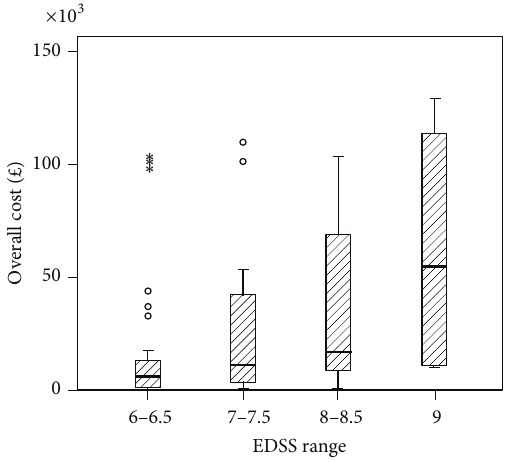
Figure 5: Box plot of overall costs for sample 𝑛 = 86